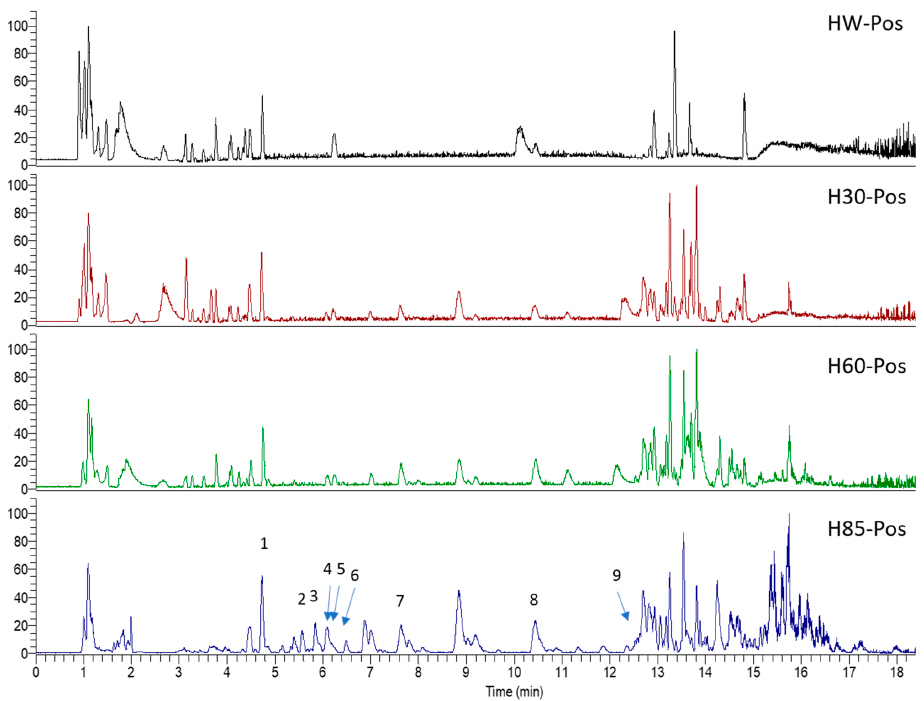
Figure 1. Ten selected active compounds in H. kouytchense insect gall extracts analyzed by UPLC–MS (positive mode).